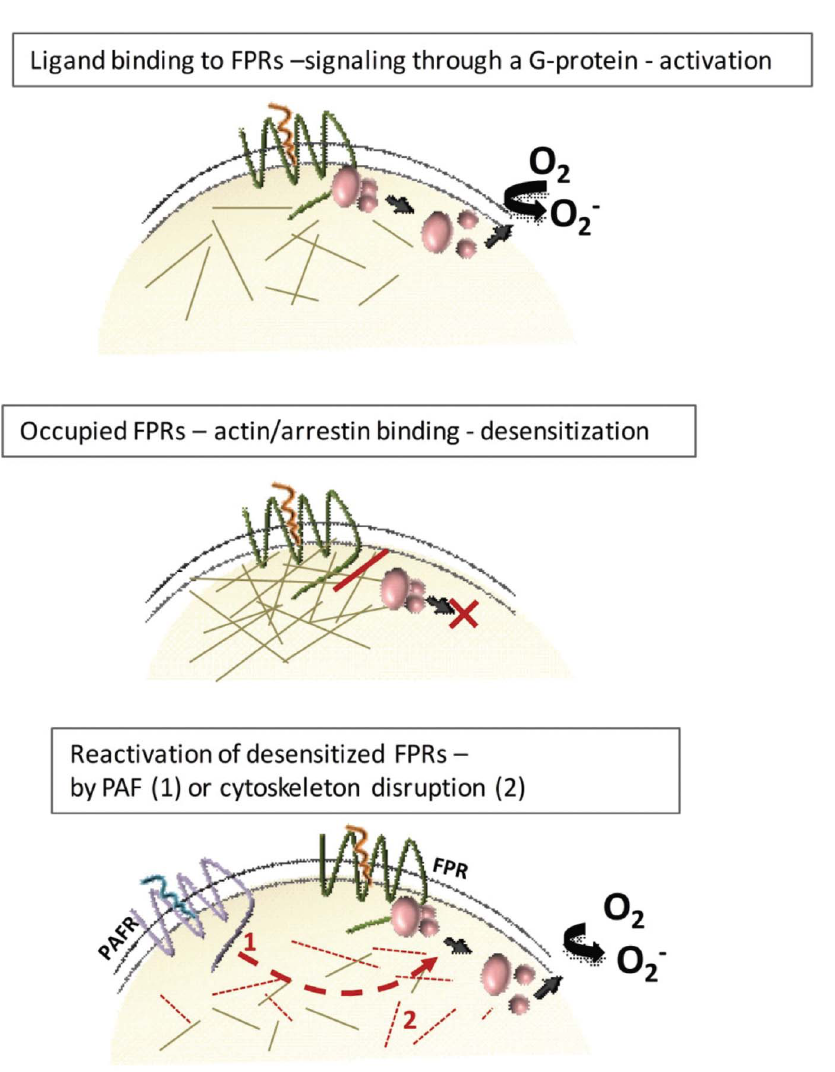
Figure 6. Model for FPR activation, desensitization and reactivation. A ) The agonist-occupied FPR activates a G-protein and the second messengers generated activate the electron-transporting NADPH-oxidase that reduces oxygen to superopxide anion. The signaling state of the receptor is fairly short lived. B ) The agonist-occupied receptor is desensitized and the functional response is terminated. This non-signaling state is hypothetically achieved through a physical separation of the receptor-ligand complex from the G-protein, made possible by binding of actin polymers and/or arrestin molecules to the receptor. C ) The desensitized FPR is reactivated by signals generated when PAF binds to its neutrophil receptor (arrow, 1). Reactivation of the desensitized FPR is achieved also with cytoskeletal inhibitors, (shorter filaments, 2), suggesting a mechanism for reactivation that involves uncoupling of the receptor-ligand complex from the cytoskeleton. The described cross talk is hierarchial and